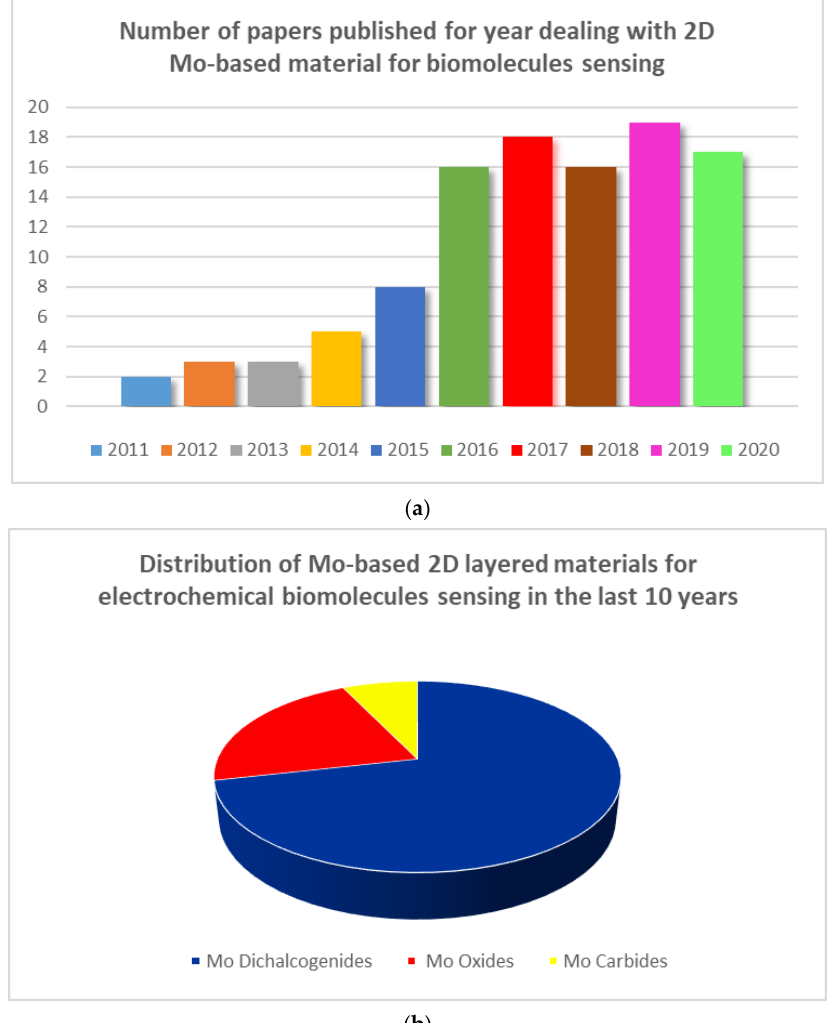
Figure 1. ( a ) Number of papers mentioning the use of molybdenum (Mo)-based materials for biomolecule sensing; ( b ) Distribution of Mo-based 2D layered materials for electrochemical biomolecule sensing.